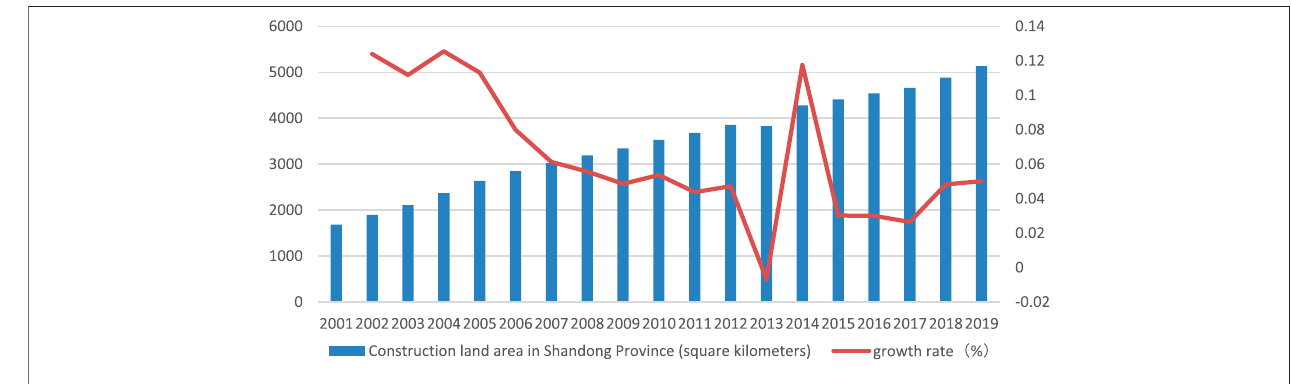
FIGURE 2 | Changes of the construction land area in Shandong province between 2001 and 2019.